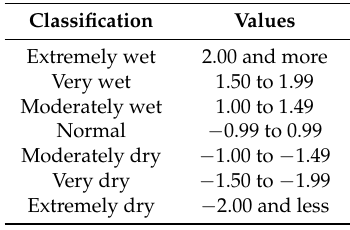
Table 2. Classification Scale for wetness and